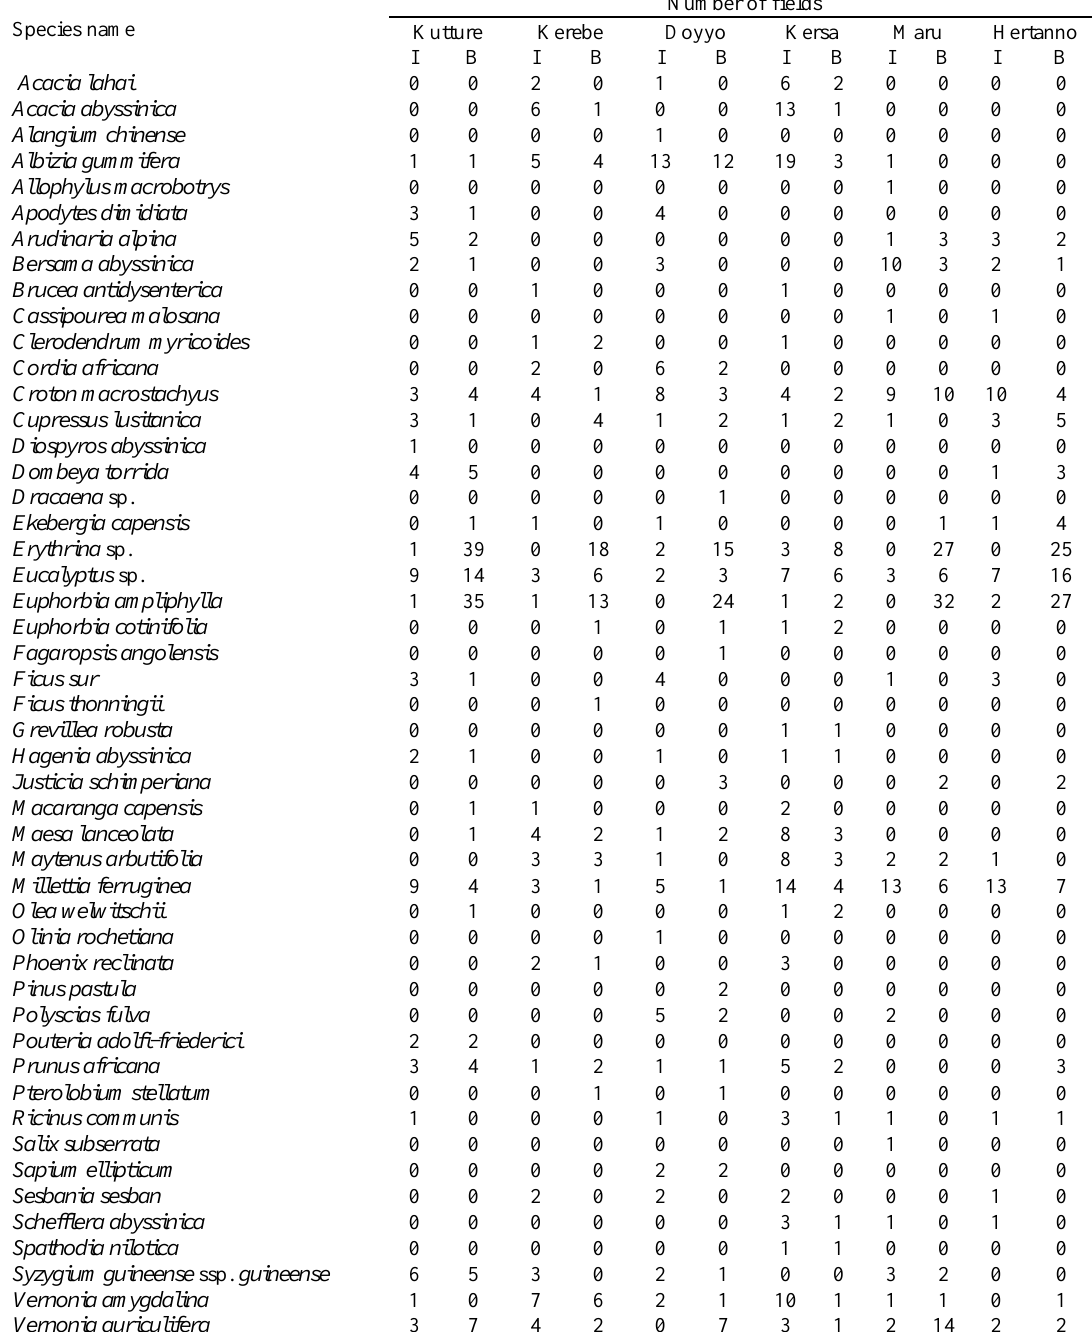
Table A2.1. Number of surveyed fields that contained tree species inside and/or on boundaries in the six villages †